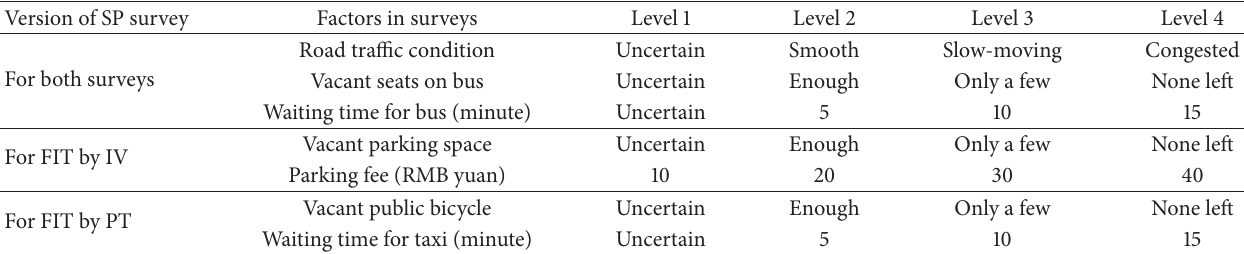
Table 3: Description of variables and levels in hypothetical scenarios.